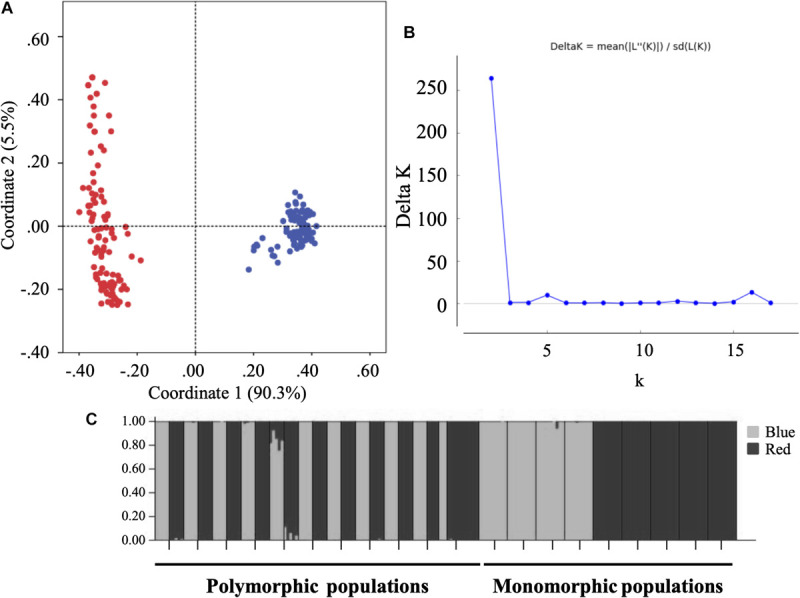
(A) Principal coordinates analysis (PCoA) based on Nei and Li distances at the individual level. (B) DK curve for detecting the number of K groups that best fits the data (Evanno et al., 2005). (C) Structure at populations level for Bayesian Analysis conducted with STRUCTURE with optimal value, K = 2; blue-flowered plants (white bars) and red-flowered plants (black bars).